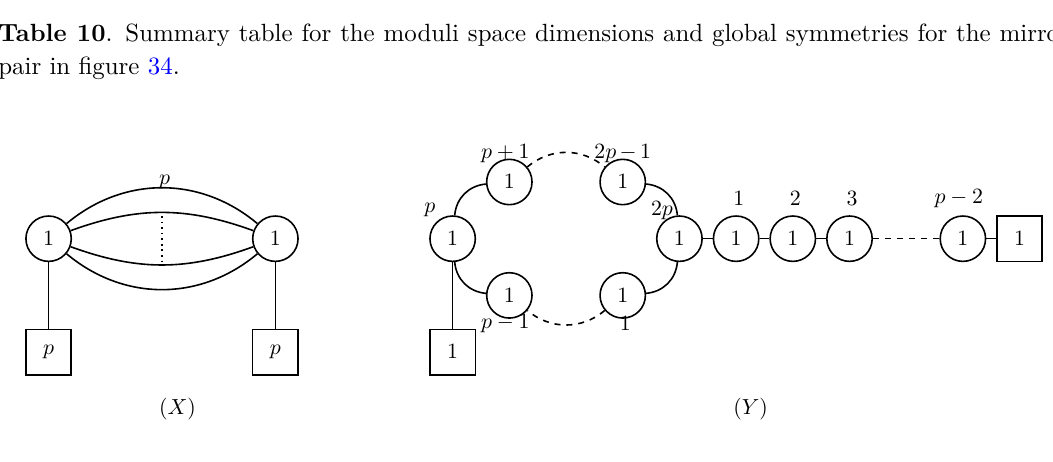
Figure 34 . The pair of Lagrangian theories associated with the 3d N = 4 SCFT that arise from the dimensional reduction of an ( A ) AD theory on a circle, for s = 2 and generic p . s , A ( s +1) p − 1 Quiver ( X ) was obtained using class S construction of AD theories, while quiver ( Y ) is the proposed 3d mirror dual of quiver ( X ) .